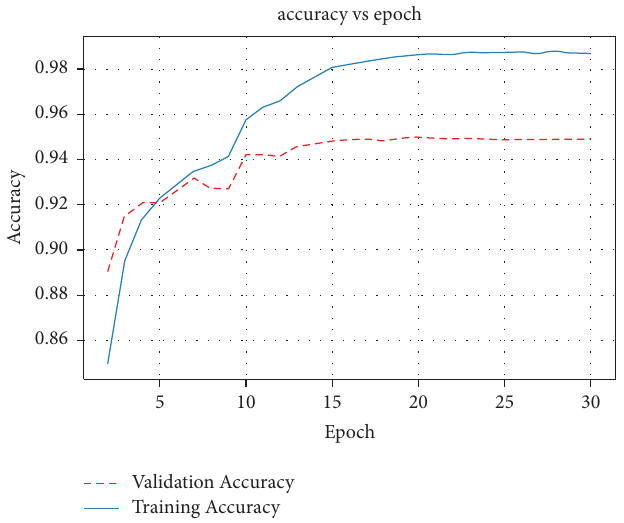
Figure 7: Observed accuracy for case 2.